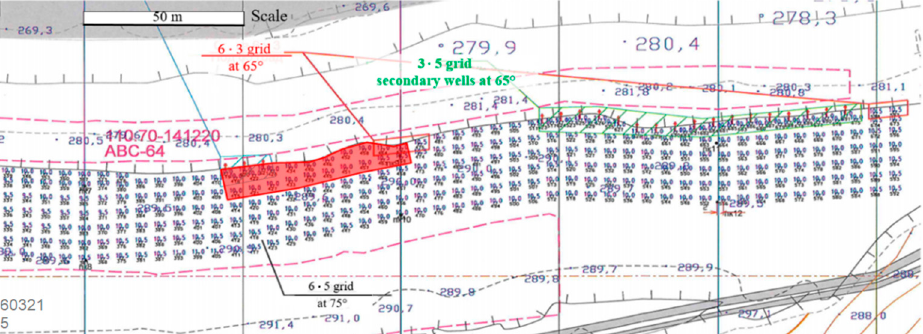
Figure 3. Arrangement of the studied boreholes No. 415–469 (highlighted in red) of block No. N 58–70 in level +285.8 to +291.2 at Novokazansky 2 site.